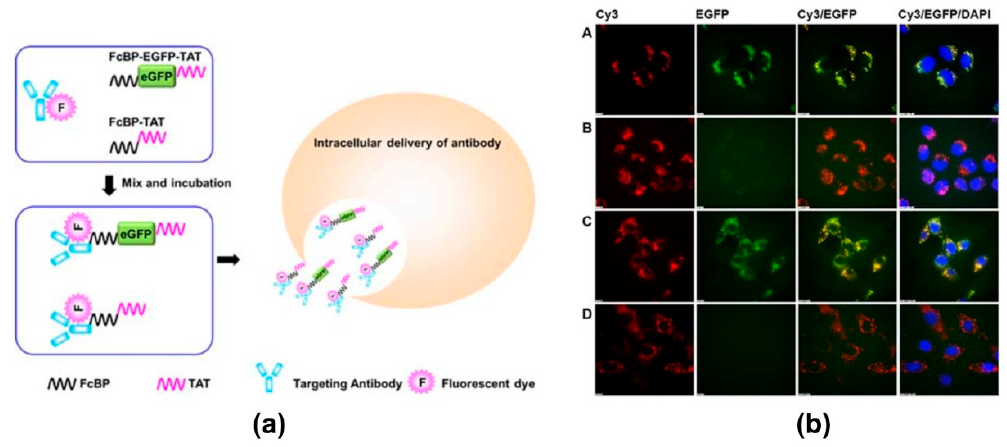
Figure 8. ( a ) Illustration of fluorescent labeled antibody delivery into live cells using the Fc-domain binding peptide (FcBP) Fc-III conjugated to the cell penetrating peptide Tat in addition to the green fluorescent protein; ( b ) Delivery of human IgG into live cells using the Fc-III/eGFP/Tat constructs. Cells were treated with Cy3 labelled human IgG (Cy3hIgG) in the presence of the Fc-III/eGFP/Tat or Fc-III/Tat. Cy3 (red): the fluorescence images of Cy3-hIgG (Ex/Em = 555/605 nm); EGFP: the fluorescence of eGFP the fluorescence (green) of eGFP (Ex/Em = 490/525 nm); Nucleus (blue) was stained with DAPI (Ex/Em = 350/455 nm); Cy3/eGFP: superimposition of Cy3-hIgG and FcBP-eGFP-Tat fluorescence images; Cy3/eGFP/DAPI: superimposition of Cy3-hIgG, FcBP-eGFP-Tat and DAPI fluorescence images. (A) HeLa cells treated with Cy3-hIgG and FcBP-eGFP-Tat; (B) HeLa cells treated with Cy3-hIgG and FcBP-Tat; (C) 3T3-L1 cells treated with Cy3-hIgG and FcBP-eGFP-Tat; (D) 3T3-L1 cells treated with Cy3-hIgG and FcBP-Tat. Adapted from [73], with permission from © 2015 Springer.